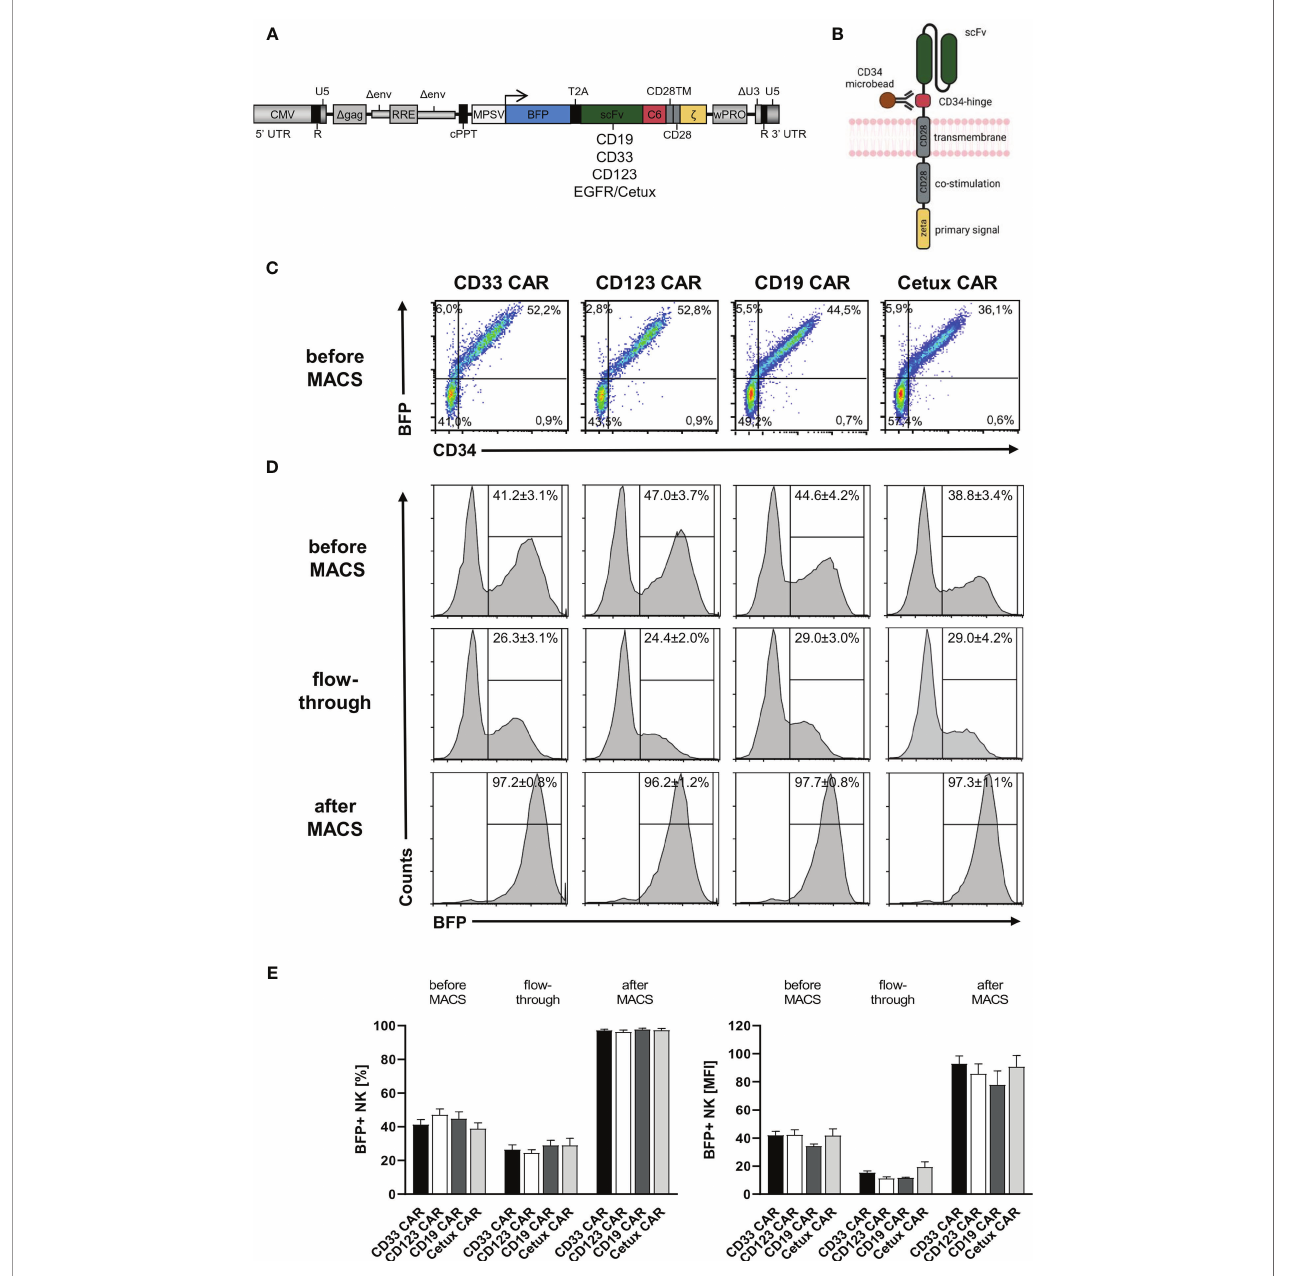
FIGURE 2 | CD34-hinged CAR expression and enrichment in primary human NK cells. Primary human NK cells were transduced with the lentiviral vectors delineated in panels (A, B) encoding BFP in cis with CD34-hinged CD33, CD123, CD19, or Cetux CARs. (B) Schematic representation of CAR construct including CD34-derived C6 hinge for microbead interactions. (C) Three to four days after lentiviral CAR transduction, NK cells were analyzed for BFP and CAR (via CD34-PE staining) expression by fl ow cytometry. Representative dot plots are shown. (D, E) CD34-hinged CAR NK cells were enriched via magnetic cell sorting using CD34 microbeads and three fractions (before MACS, fl owthrough, and after MACS) were analyzed for the content of NK cells expressing BFP by fl ow cytometry. The histogram blots show representative data. Data are represented as mean ± SEM of at least four biological